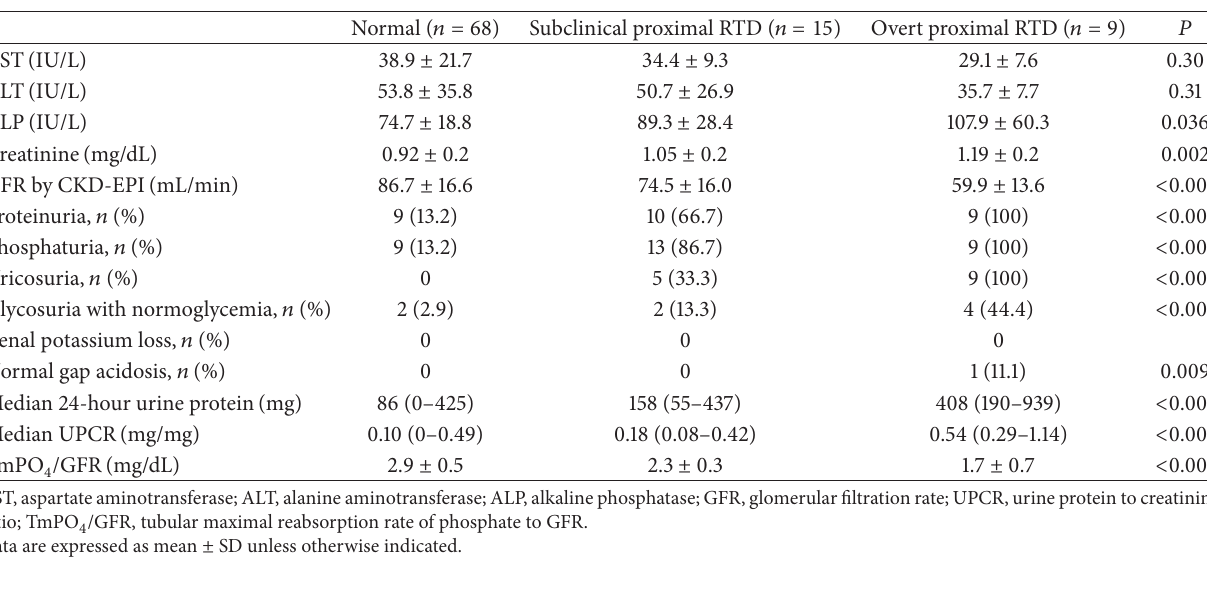
Table 2: Blood and urine chemistries of 92 patients treated with nucleotide analogues according to the severity of proximal renal tubular dysfunction (RTD).